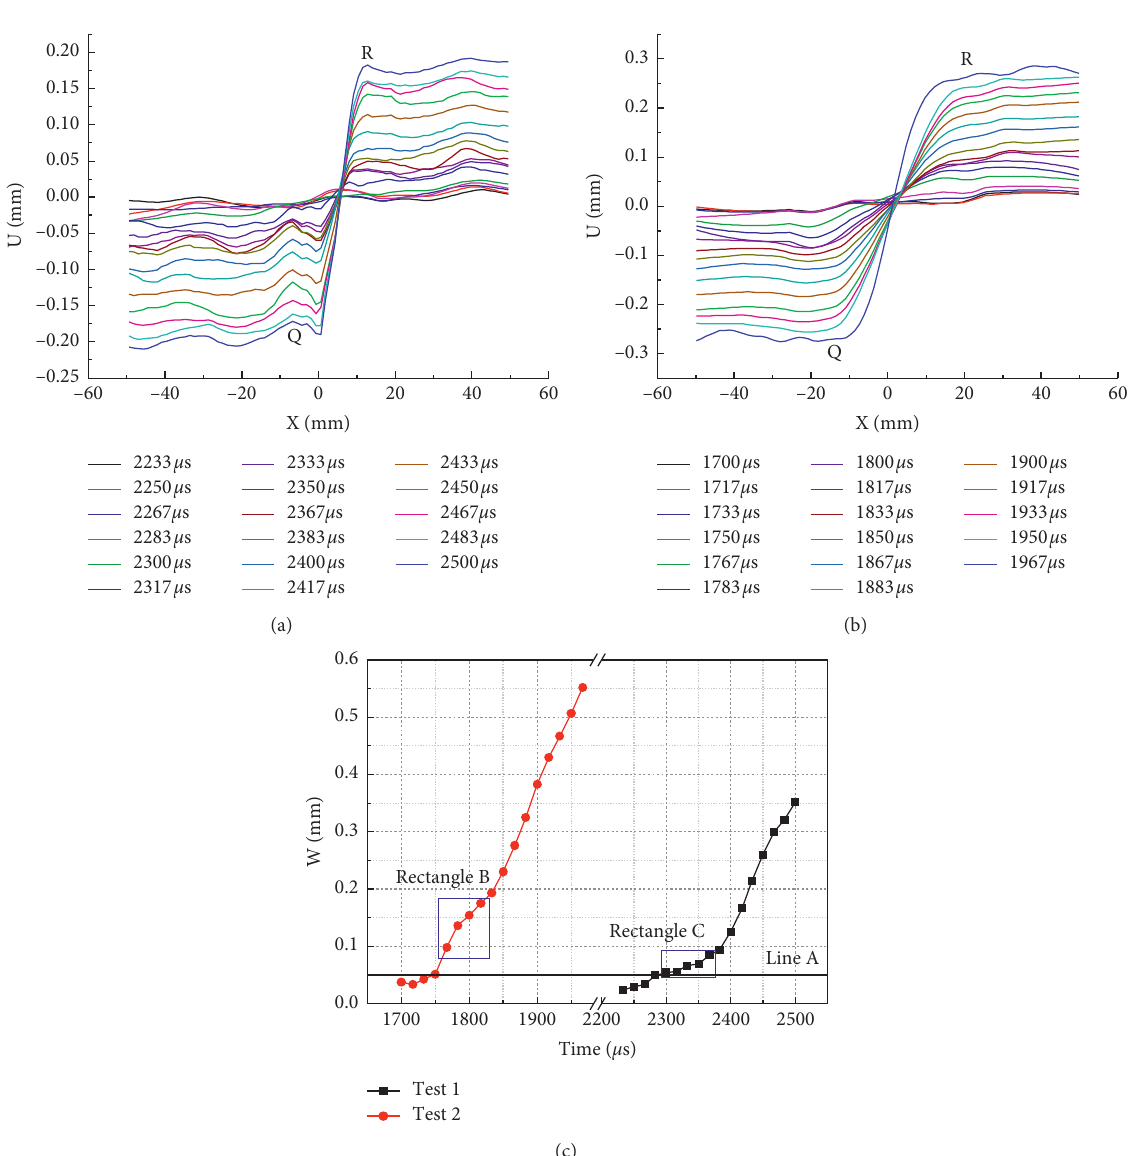
Figure 16: Displacements along LOI 4. (a) Test 1, (b) test 3, and (c) crack